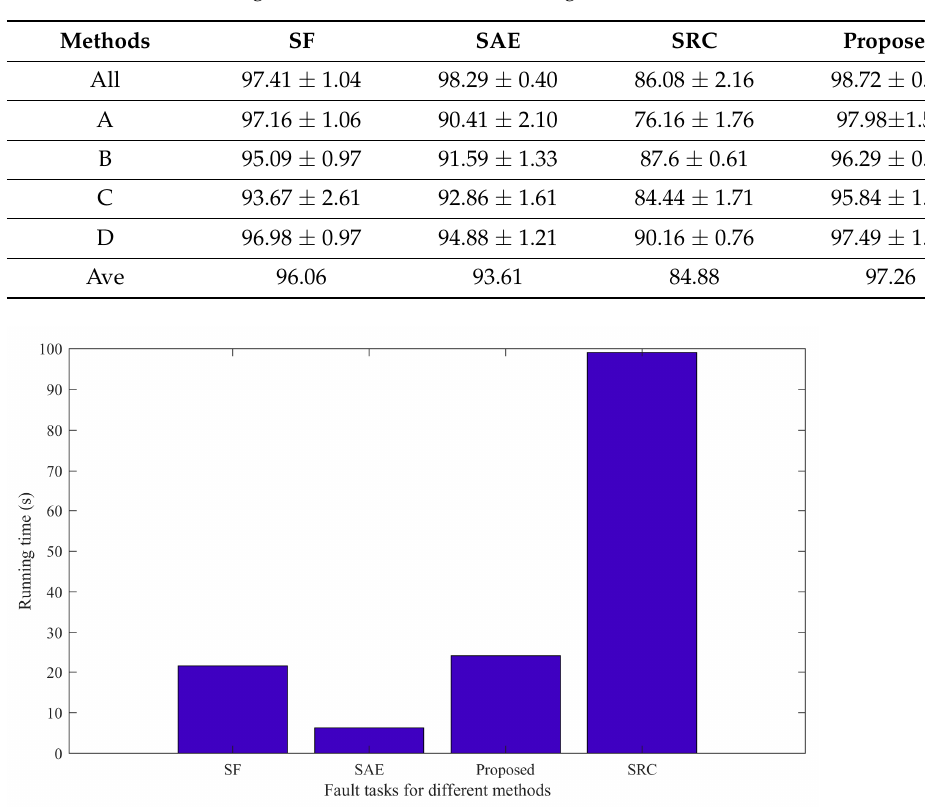
Figure 5. Running time for different methods. Table 2. The detailed diagnostic results (%) of the bearing